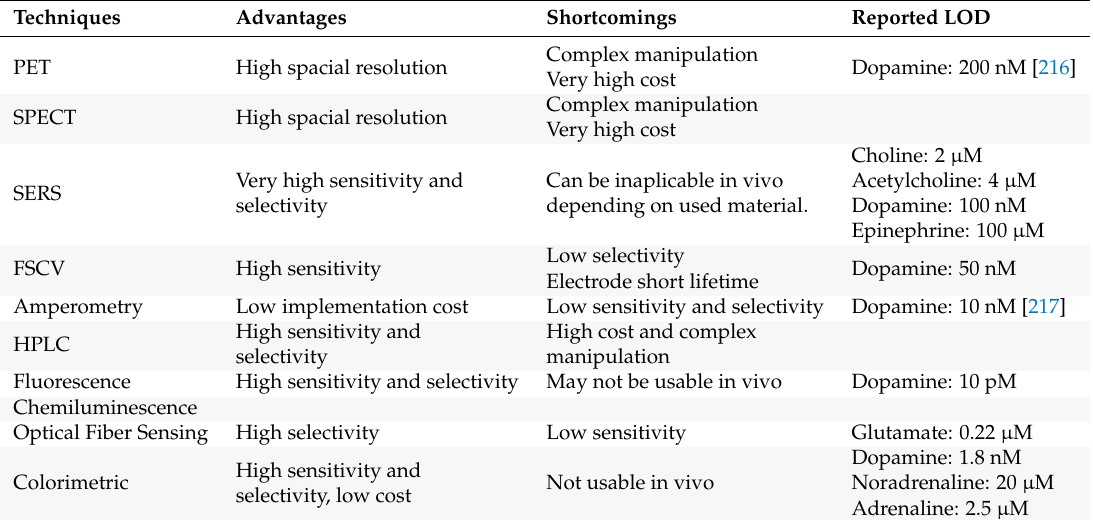
Table 2. Summary of neurotransmitters’ detection